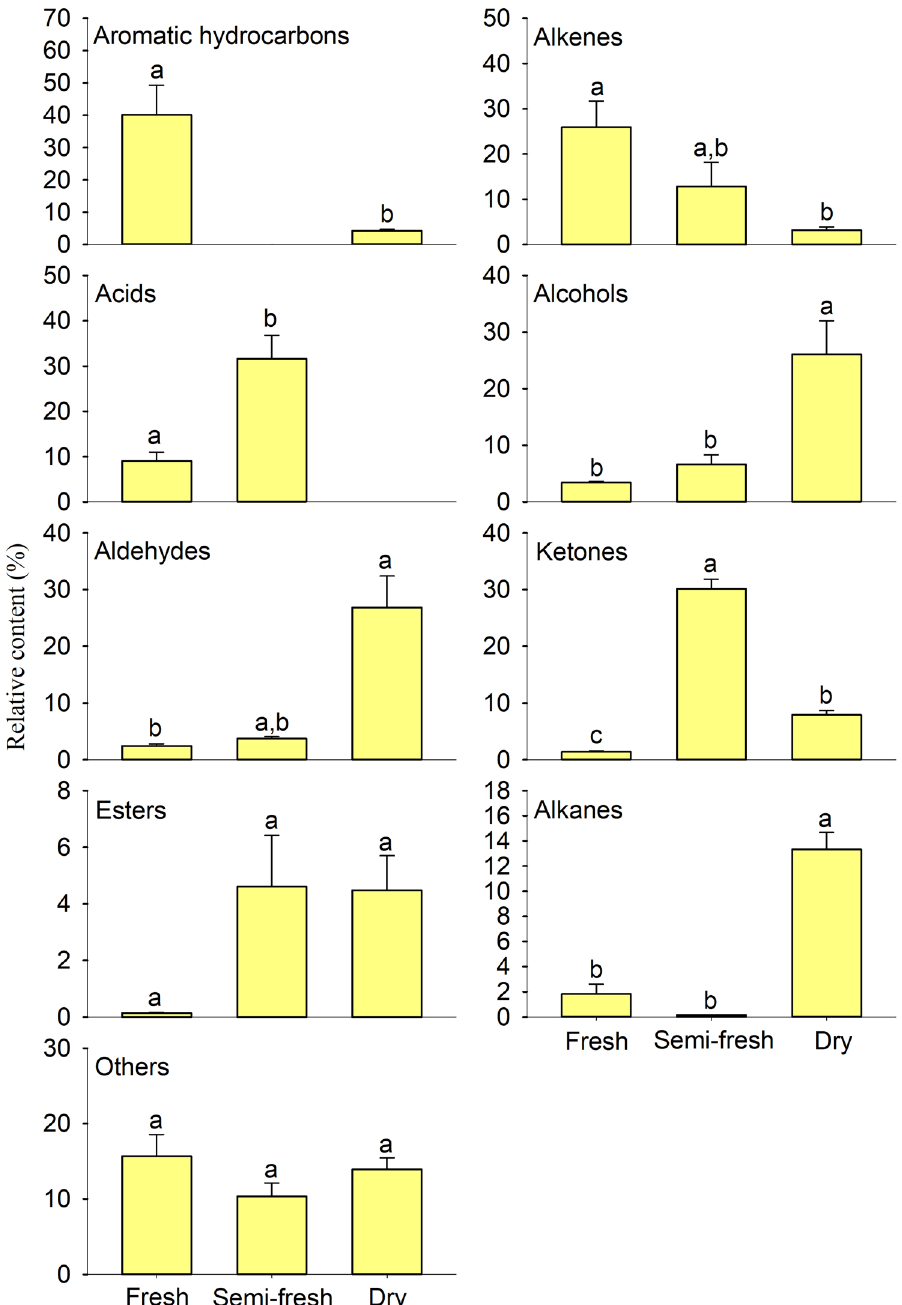
Figure 3. Volatile classes detected from feces of Przewalski’s horse with different freshness states at the OVIP stage of Gasterophilus pecorum. Fresh, Semi-fresh, and Dry represent fresh, semi-fresh, and dry feces at the oviposition (OVIP) stage of Gasterophilus pecorum , respectively. Data are mean (n = 3) ± SE. Different letters indicate significant differences at P <